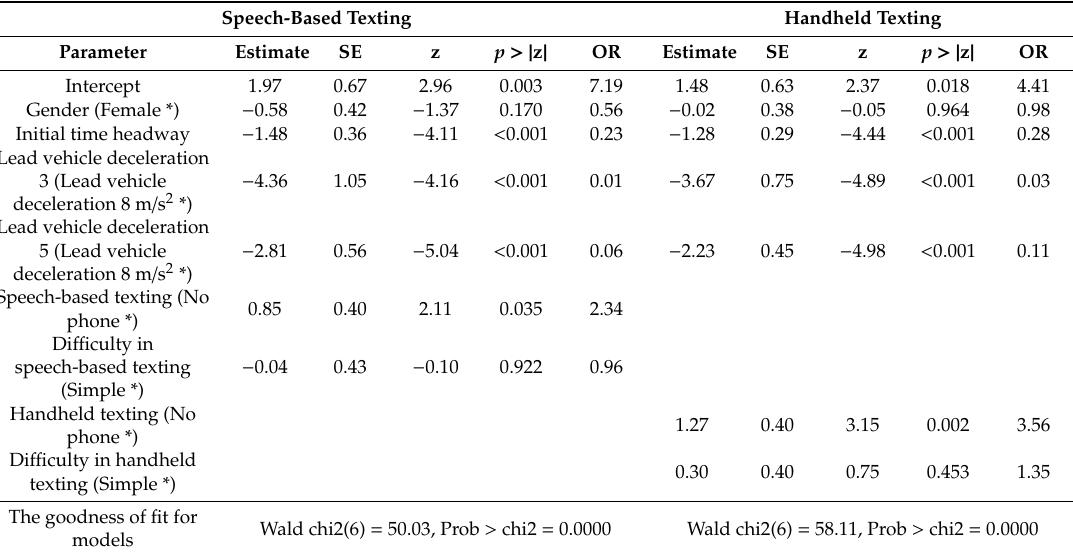
Table 3. Model results for rear-end accident risk across di ff erent driving conditions. Speech-Based